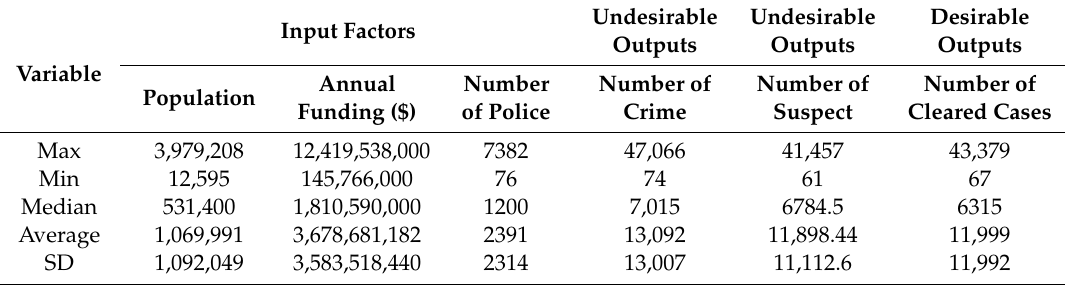
Table 2. Summary statistics of inputs and outputs for 22 counties / cities.